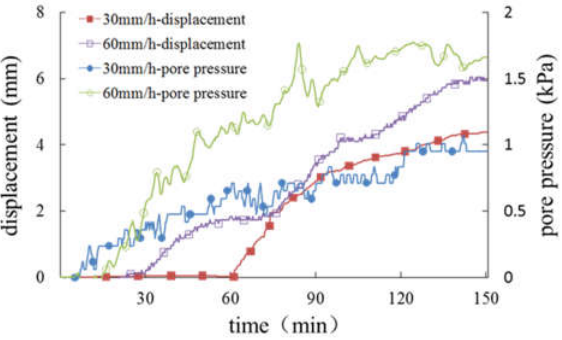
Figure 21. Curves of displacement and pore pressure in the slope without weak layer.